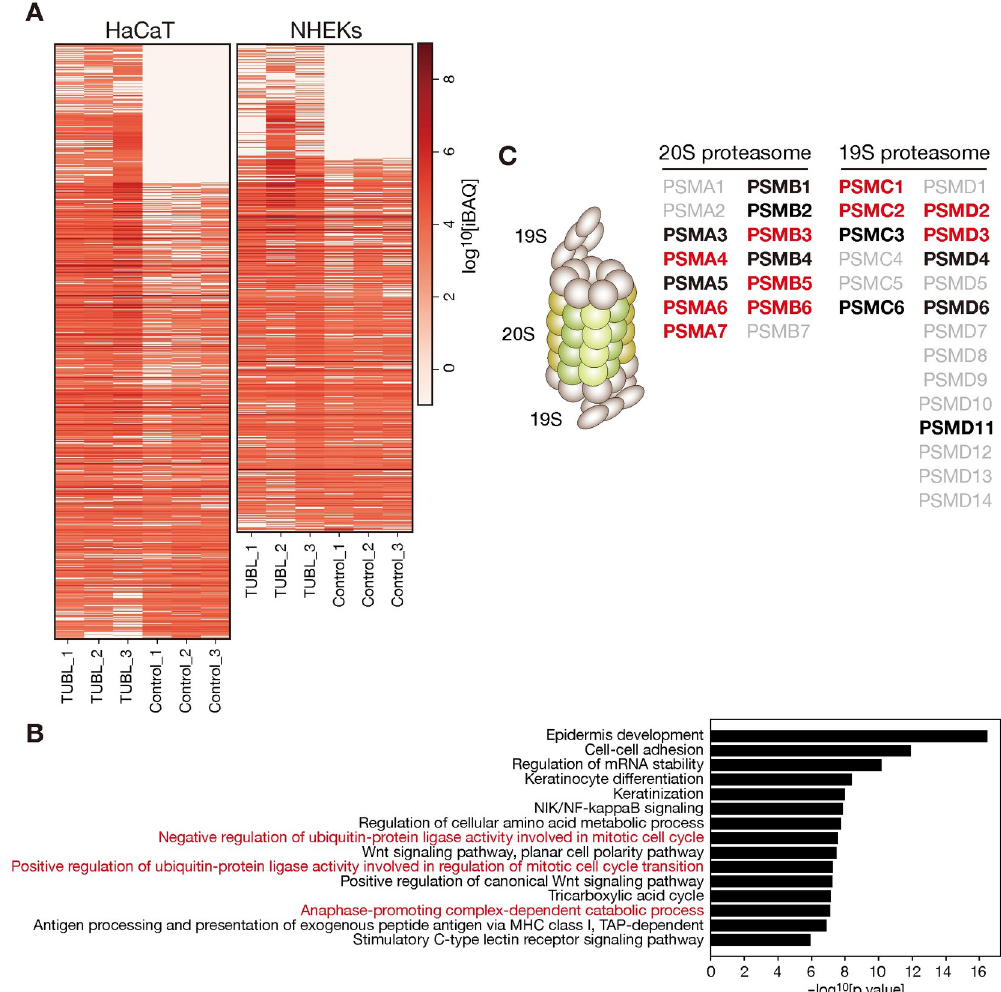
Fig 7. Identification of TUBL binding proteins. (A) Heat map of iBAQ (intensity-based absolute quantification) values for HaCaT cells or NHEKs transiently expressing human TUBL with a COOH-terminal FLAG tag or transfected with the corresponding empty vector (Control). Immunoprecipitates prepared from the cells with antibodies to FLAG were subjected to semiquantitative LC-MS/MS analysis. Data are shown for three biological replicates. (B) GO analysis of identified TUBL binding proteins. Representative findings are presented. (C) Schematic representation of the proteasome complex (left) and lists of proteasome subunits identified as TUBL binding proteins (right). 19S and 20S indicate the 19S regulatory particle and 20S catalytic particle of the proteasome, respectively. Red and black characters indicate subunits identified in both HaCaT cells and NHEKs or in one of the two cell types, respectively.